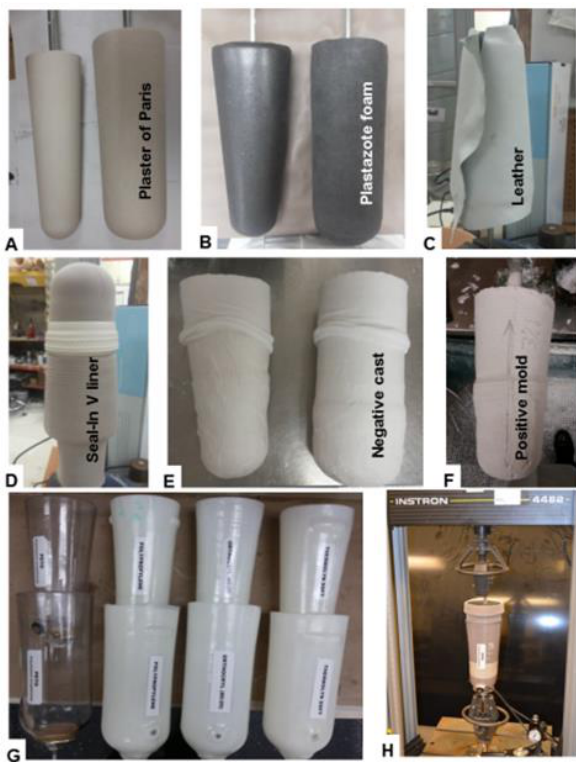
Figure 2 : Sockets fabrication and mechanical testing. A-G: Process of making cylindrical and conical sockets; H: mechanical testing.